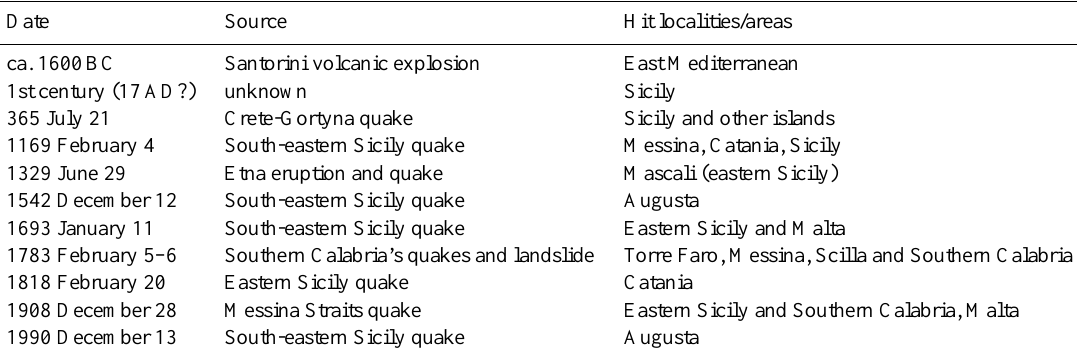
Table 1. Historical tsunamis affecting the coast of eastern Sicily (data from Boschi et al., 2000; Tinti et al., 2007; Gerardi et al., 2008; Barbano et al., 2009 and references